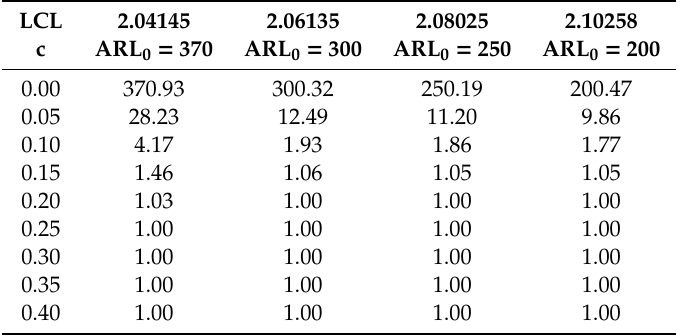
Table 8. The ARLs for the proposed chart when n = 50, GD (9.0,0.45), USL = 8.3602, and LSL = 1.4096.